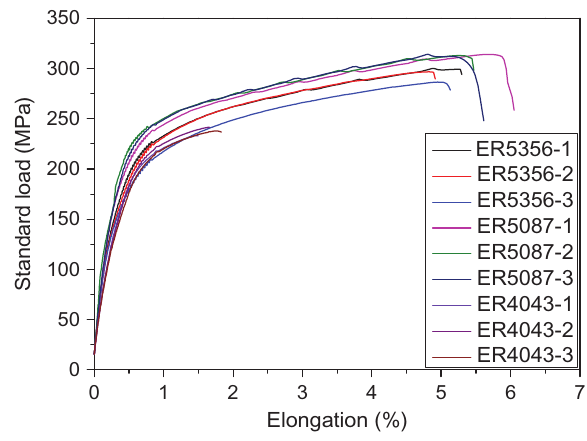
Figure 10: The tensile